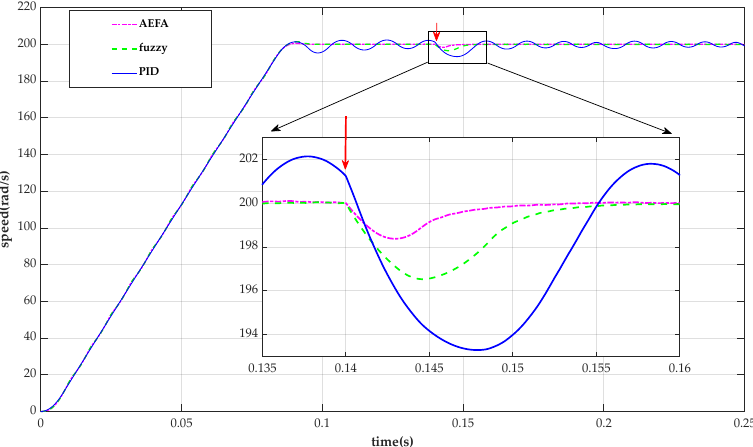
Figure 11. Speed response of BLDC motor for three controllers under no-load condition.